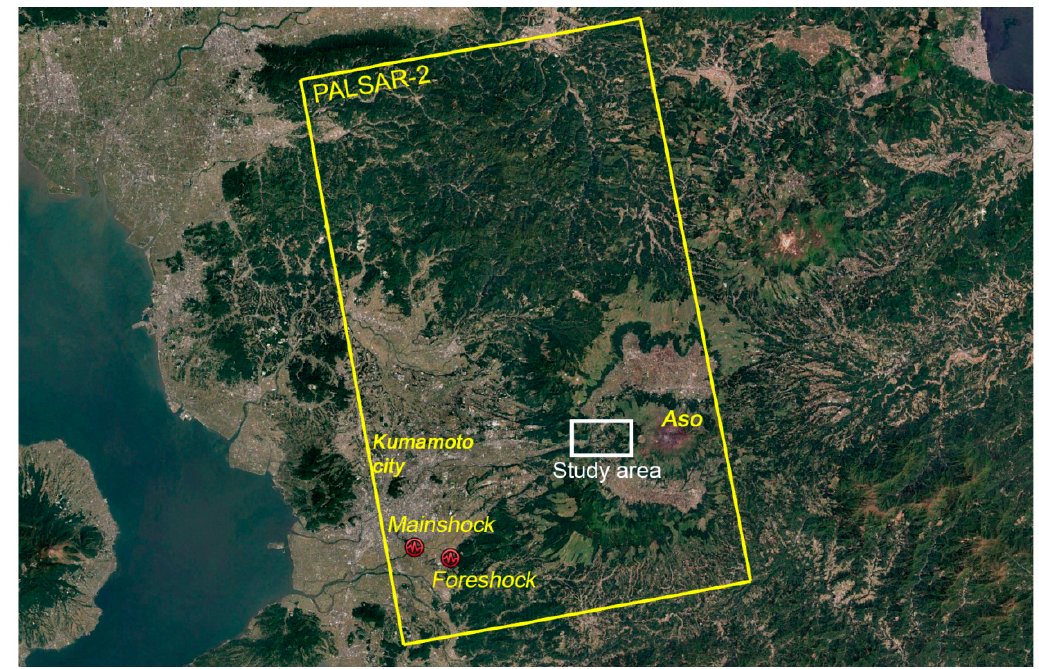
Figure 1. Location of the foreshock and mainshock of the 2016 Kumamoto earthquake and ALOS-2 PALSAR-2 data coverage. Boxed area in the PALSAR coverage is the Minamiaso study site in which many landslides occurred during the earthquake.